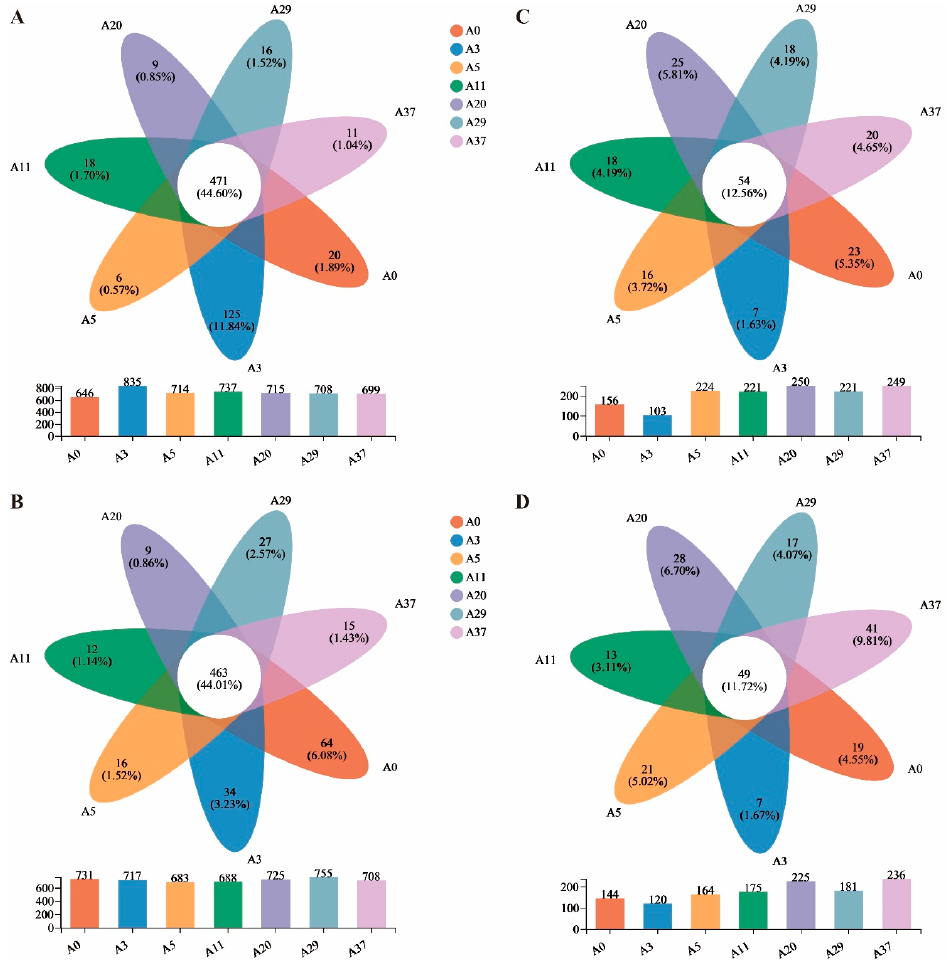
Figure 2. Venn diagram at OTU level of bacterial community (( A ), 0–10 cm; ( B ), 10–20 cm) and fungal community (( C ), 0–10 cm; ( D ), 10–20 cm) for different stages of afforestation by aerial sowing in the northeastern Tengger Desert, China.